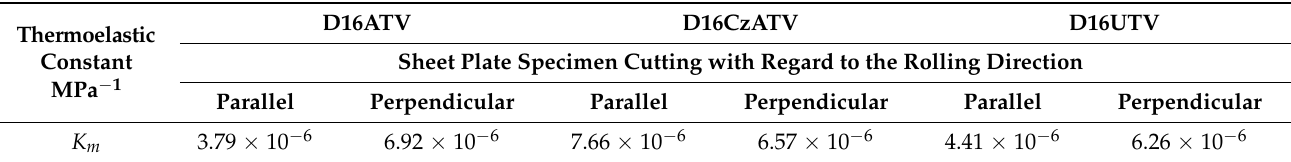
Table 12. A summary of the thermoelastic material constant K m for sheet plate made of D16 aluminum alloy depending on the thickness and the rolling